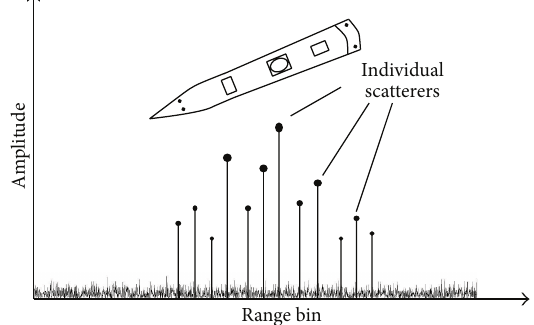
Figure 5: Ship and high range resolution